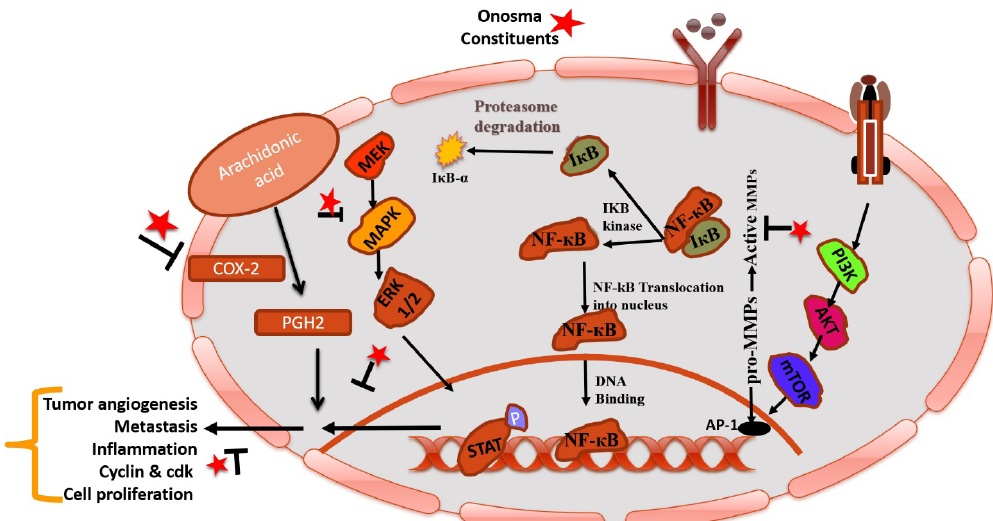
Figure 3. Pictorial representation of mechanistic insight of phytoconstituents of O . in cancer by modulating COX-2 and NF-κB. IκB-α: NF-κB inhibitor alpha; Iκβ: I-kappa-beta; IKB: inhibitor of NF-κB kinase; STAT: signal transducer and activator of transcription; MEK: mitogen-activated protein kinase kinase; PGH2: prostaglandin H2; mTOR: mammalian target of